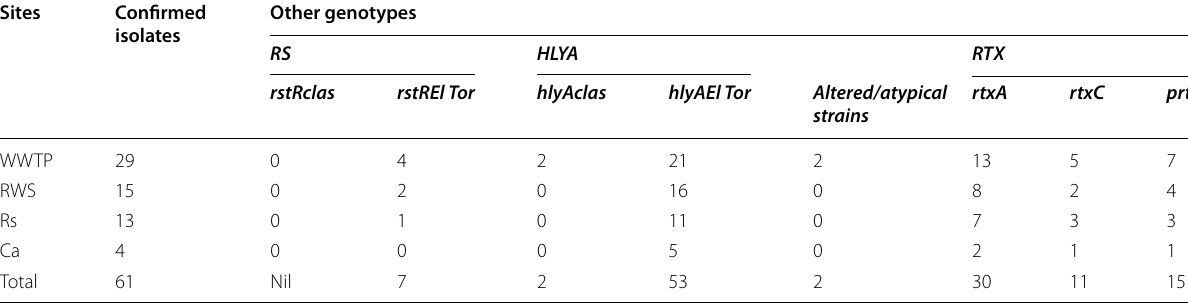
Table 4 Numbers of other genotypes detected for atypical V. cholerae and other members Sites Confirmed